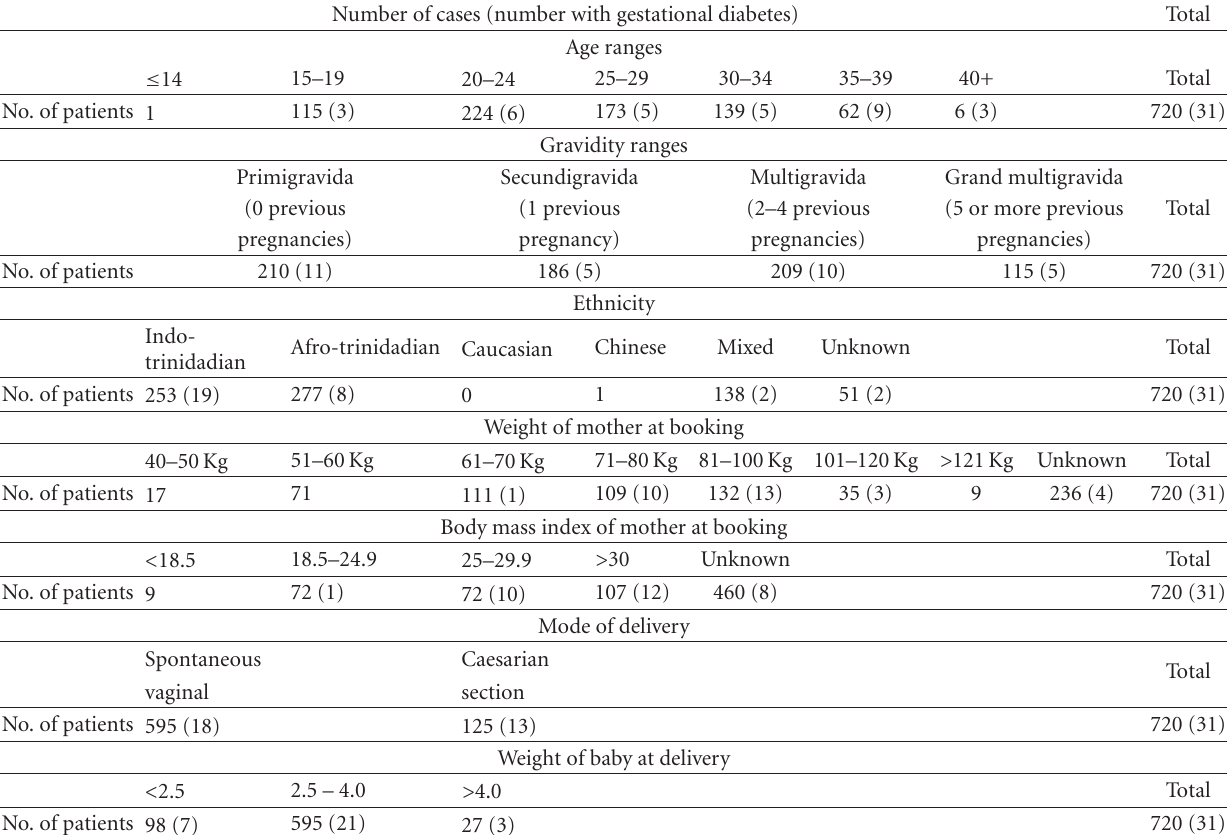
Table 1: Demographics of study